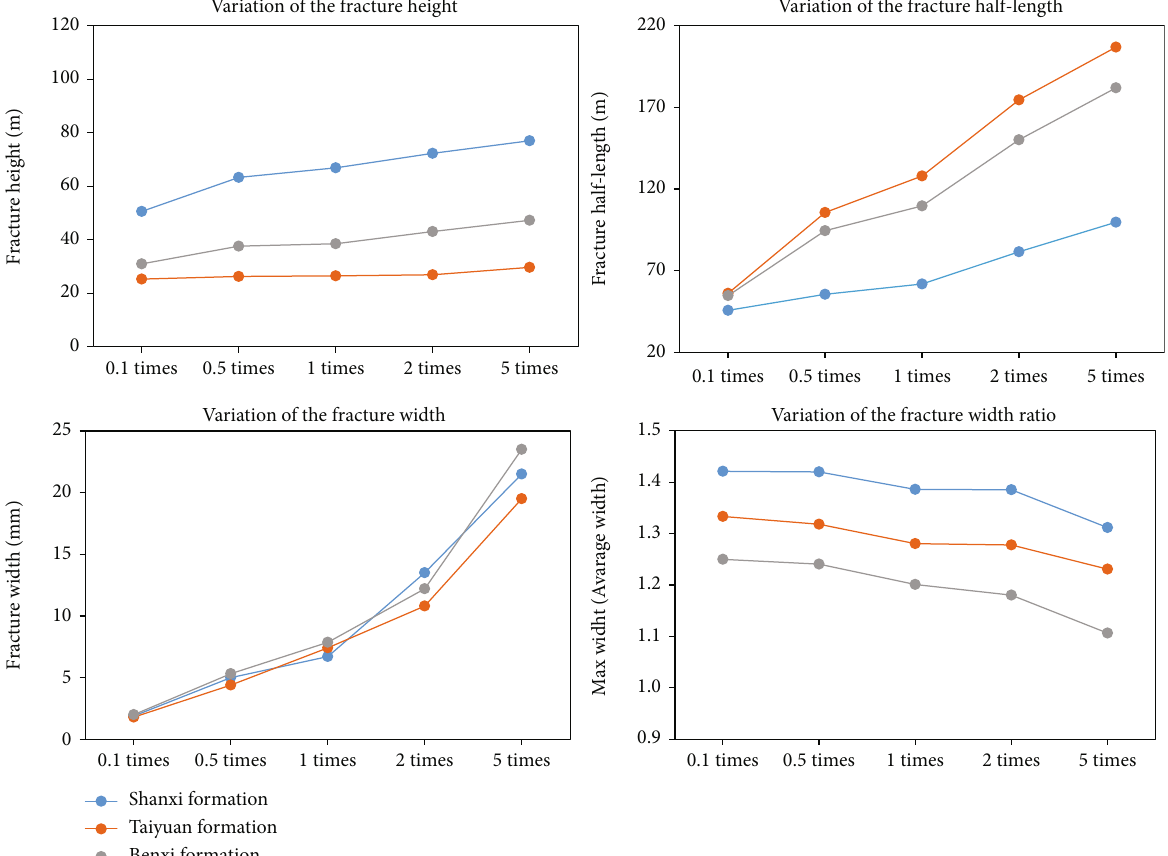
Figure 12: Variation of hydraulic fracture shape with the fracturing fl uid injection